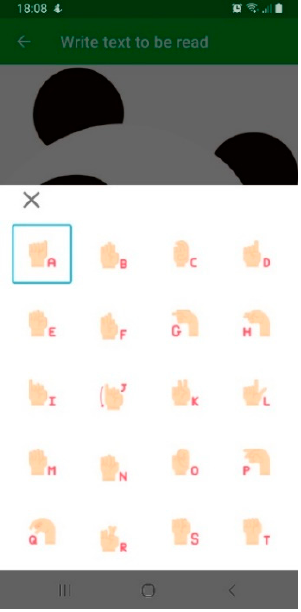
Figure 11. PandaSays Sign language screen with TalkBack on.